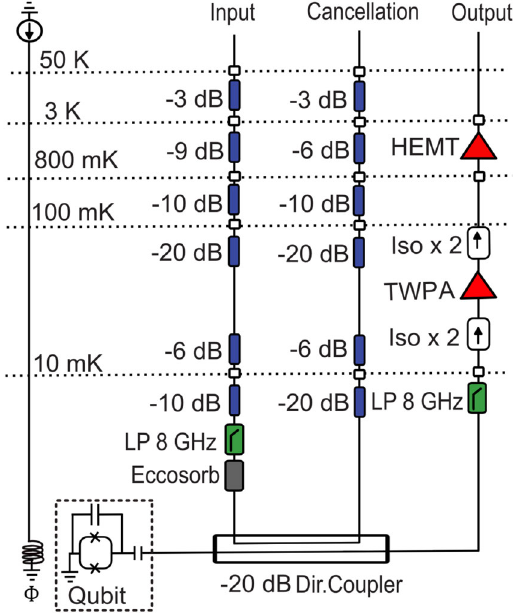
Fig. 7 The measurement setup. LP, Iso, HEMT, and TWPA denote low-pass fi lters, isolators, a high electron mobility transistor ampli fi er, a traveling-wave parametric ampli fi er.